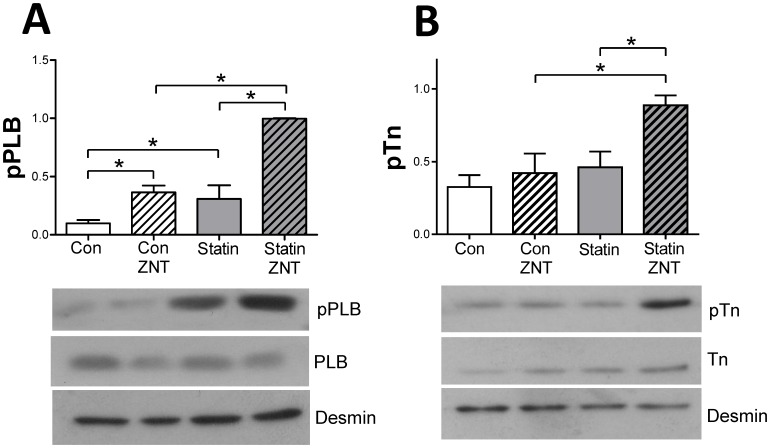
Simvastatin treatment modulates phosphorylation of PLB and TnI following β2-AR stimulation.A. Representative immunoblots and mean data showing levels of Ser16 phosphorylated phospholamban (pPLB) under basal conditions and following β2-AR stimulation with 100 nM zinterol (ZNT) +10 nM CGP20712A. B. Representative immunoblots and mean data showing levels of Ser23/24 phosphorylated troponin I (pTnI) under basal conditions and following β2-AR stimulation. Simvastatin had no significant effect (P>0.05) on expression of PLB or TnI. All phosphorylated protein data are normalised to desmin expression. n = 4 hearts. * P<0.05, 2-way ANOVA.